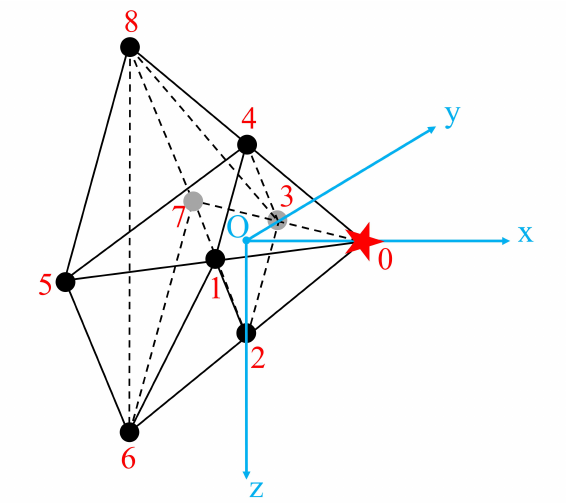
Figure 3. Desired